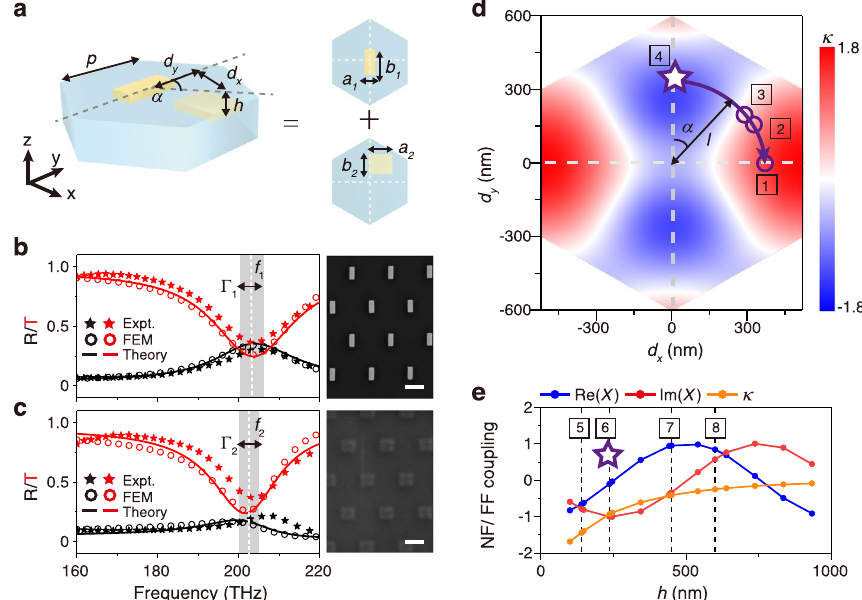
Fig. 4 Optical properties of two basic resonators and their NF and FF couplings. a A unit cell of the bi-layer metasurface containing one Au nano bar on top of a SiO 2 substrate and another Au nano bar buried inside the substrate at a depth h . Here the two resonators are of the same thickness (30 nm) and different lateral sizes, with their centers on different lateral positions on the xy -plane. b Spectra of reflectance/transmittance 140 nm and b 1 340 nm) arranged in a hexagonal of the metasurface containing top resonators (with a 1 = = lattice with periodicity p 600 nm, obtained by experiments (stars), simulations (circles) and CMT calculations = (solid lines) with parameters computed by the LEM theory ( f 1 203.32 THz, Γ 1 r 5.997 THz, Γ 1 i 6.140 THz). c = = = Spectra of reflectance/ transmittance of the metasurface containing resonators (with a 2 320 nm and = b 2 280 nm) buried inside the substrate at h 236 nm arranged in a hexagonal lattice with periodicity = = p 600 nm, obtained by experiments (stars), simulations (circles) and CMT calculations (solid lines) with = parameters computed by the LEM theory ( f 2 202.57 THz, Γ 2 r 4.985 THz, Γ 2 i 4.975 THz). White dashed lines = = = and gray areas in b - c denote the frequencies and radiation damping of the resonant modes, calculated by LEM theory, and right panels in b - c are the SEM images of the fabricated samples with scale bars (white lines) of 500 nm. d LEM-calculated near-field coupling κ between two resonators versus their relative lateral configuration ( d x , d y ) with fixed vertical distance h 236 nm. Points labeled with 1–4 represent the cases with = 345 nm . e LEM-calculated inter-resonator couplings ( X and d 2 x d 2 y α 90 ∘ , 65 ∘ , 55 ∘ , 0 ∘ on the circle l = (cid:31) + = = 345 nm . Dashed lines labeled with #5–8 represent d 2 x d 2 y κ ) as functions of h , with fixed α 0 ∘ and l = = (cid:31) + = the cases with h 140, 236, 450, 600 nm, respectively. The violet star represents the position of critical point = with κ Im( X ) 0 and θ X π /2 satisfied. Here, κ and X are scaled by √ Ŵ 1 r Ŵ 2 r , and the SiO 2 substrate has a − = = thickness of 500 μm in experiments and is treated as a semi-infinite medium in